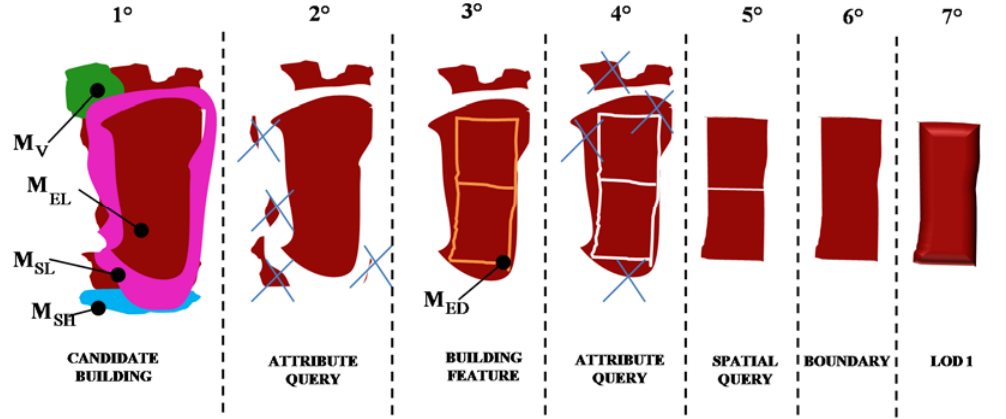
Figure 4. From blob-polygons to building detection phases.